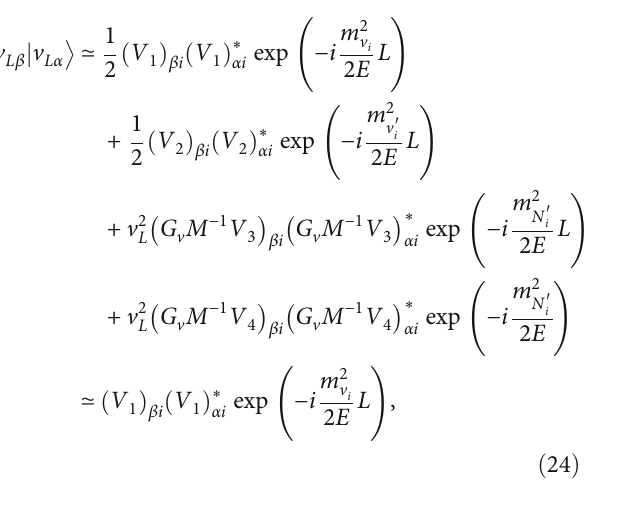
Figure 4: Process η → u